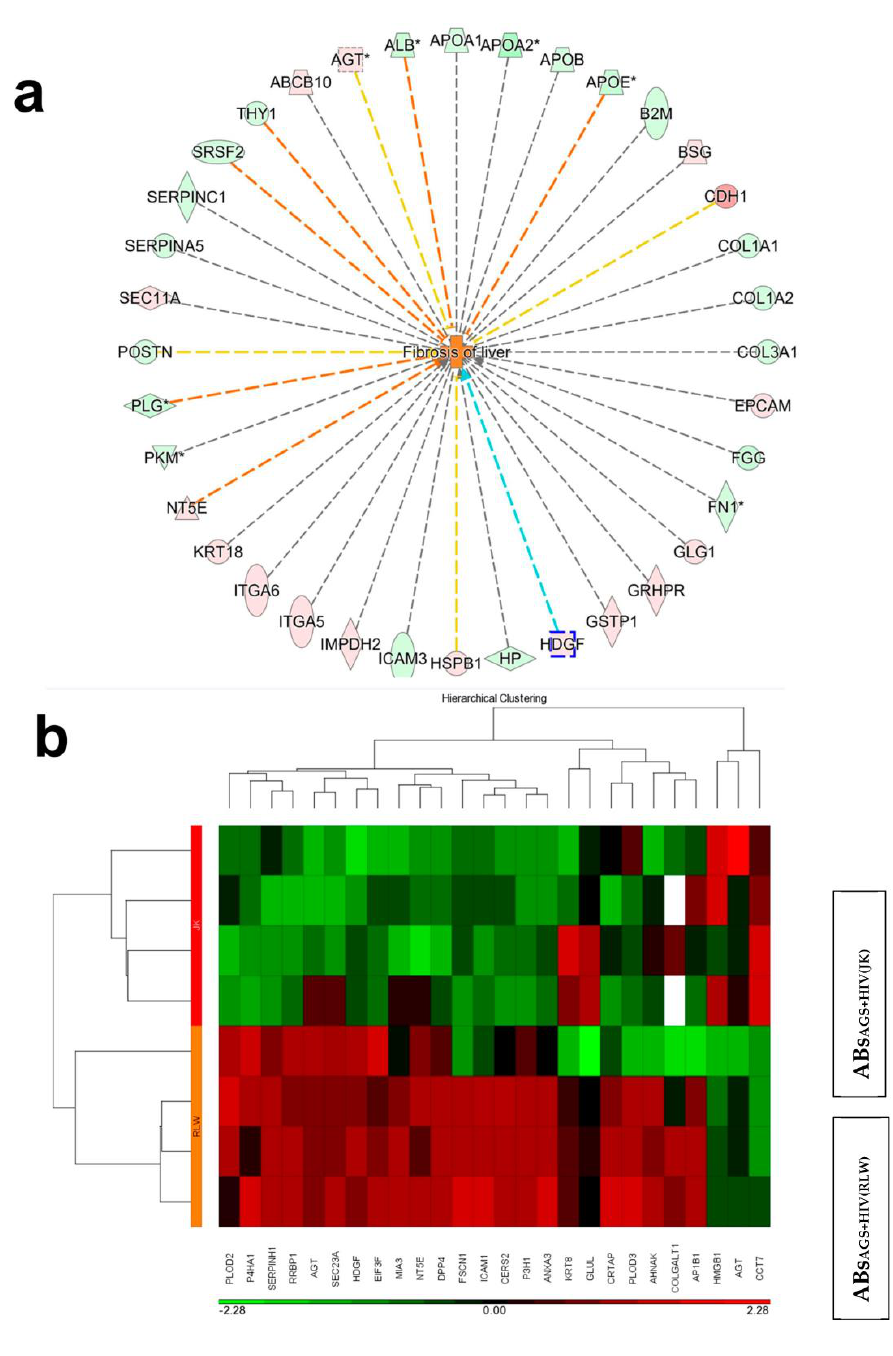
Figure 4. Characterization of proteins associated with liver fibrosis in hepatocyte vs. lymphocyte ABs by mass spectrometry ( a ) ingenuity pathway analysis showing the top 36 proteins associated with liver fibrosis. The green color represents downregulated proteins in AB AGS+HIV(RLW) vs. AB AGS+HIVJK and the pink color represents upregulated proteins of AB AGS+HIV(RLW) vs. AB AGS+HIVJK . Proteins with asterisk (*) indicates that several identifiers in the data link to a single gene in the Global Molecular Network ( b ) Heatmaps of top 26 proteins of hepatocyte ABs vs. lymphocyte ABs. The red color represented upregulated proteins of AB AGS+HIV(RLW) vs. AB AGS+HIVJK ; the green color represented downregulated protein of AB AGS+HIV(RLW) vs. AB AGS+HIVJK ; black color represented an equal amount of proteins in AB AGS+HIV(RLW) and AB AGS+HIVJK . Data significantly different from each other ( p ≤ 0.05) are from 4 independent